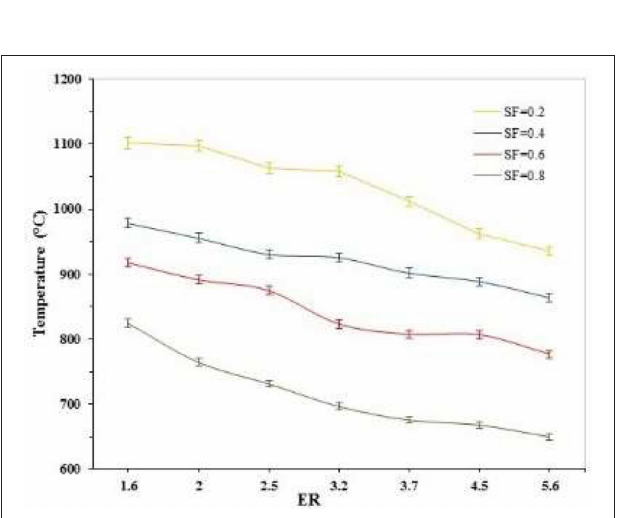
FIGURE 3 | Temperature peaks vs. ER for several SF ratio values for air and oxygen gasification of CH.